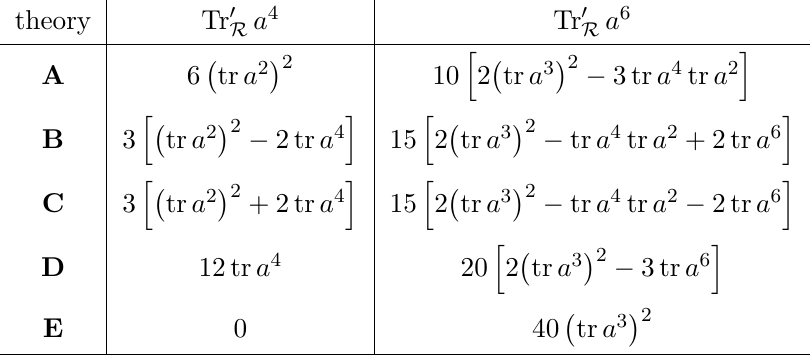
Table 2 . The quartic and sextic interaction terms in the action S ( a ) for the (cid:12)ve families of conformal theories de(cid:12)ned in table